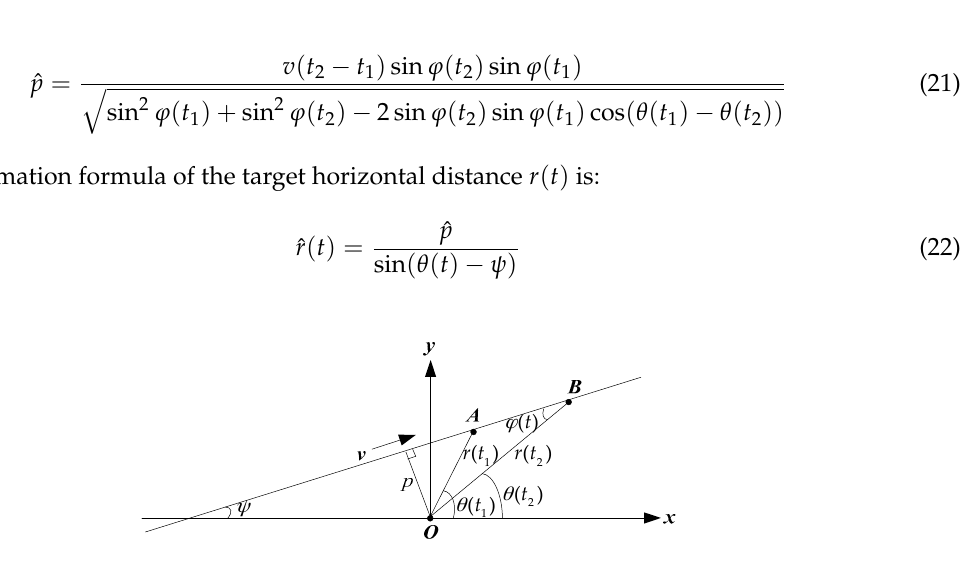
Table 1. The simulation parameters. Figure 5. The track geometry diagram of the aerial target in the horizontal plane.